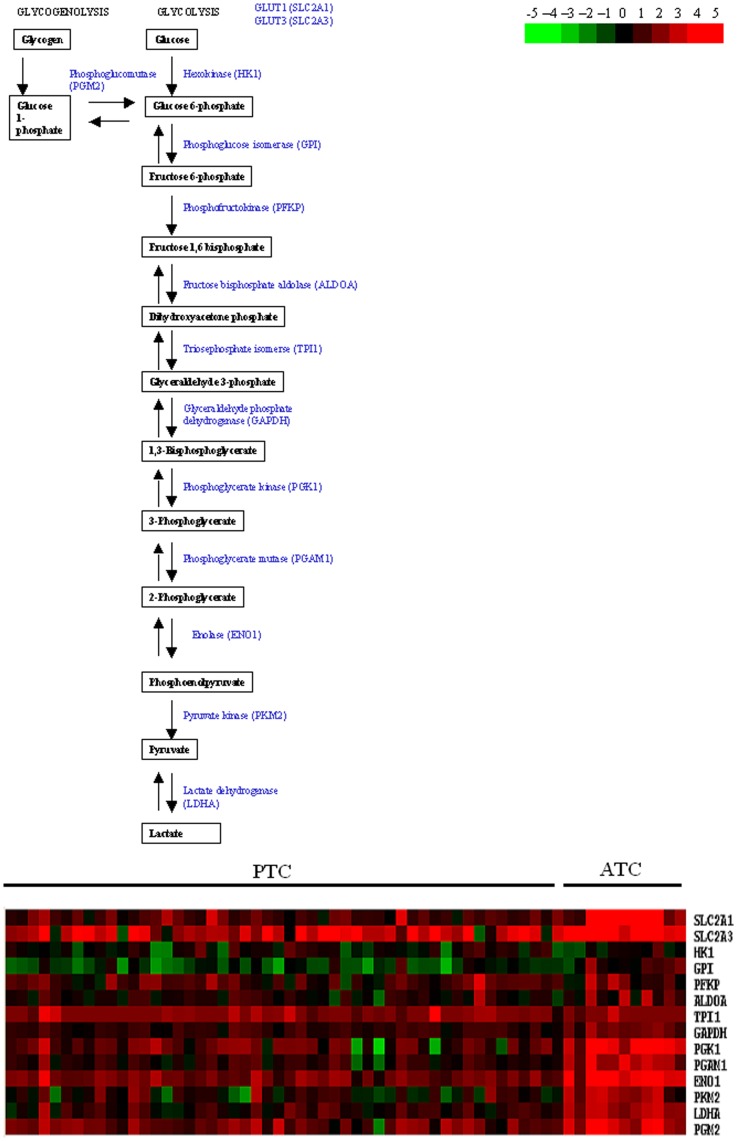
Glycolysis pathway and heatmap with the gene expressions of the intermediate enzymes in ATC and PTC.